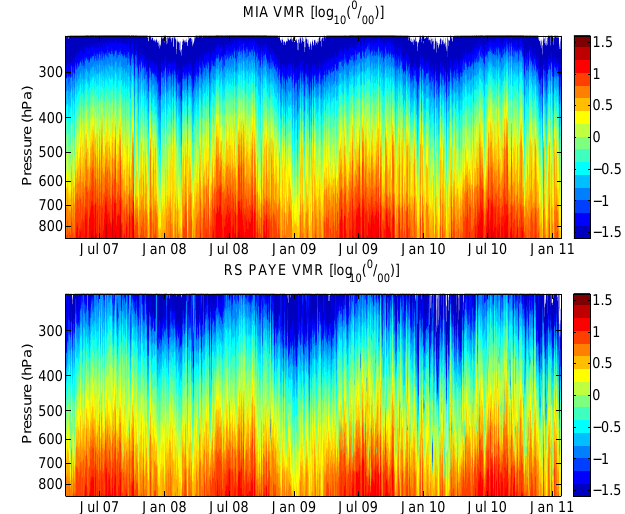
Fig. 12. H 2 O vmr retrieved from MIAWARA (4h averaged spectra, top plot) and operational balloon soundings performed at Payerne, regridded to MIAWARA grid (bottom plot). Shown data are re- stricted to cases with near time-coincident sounding and retrieval profiles (mostly two cases per